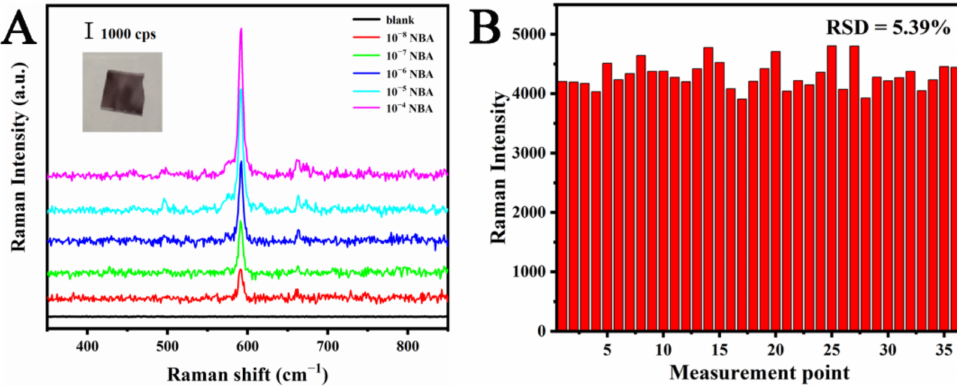
Figure 3. ( A ) SERS spectra of aqueous solutions containing different concentrations of NBA. ( B ) SERS intensity of NBA at 590 cm − 1 from 36 random detection points on the same MC/Ag NPs